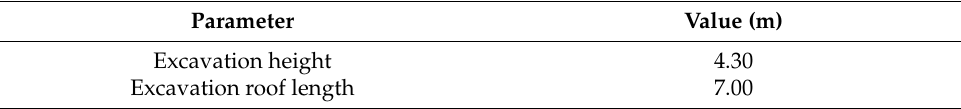
Table 1. Geometric cross-section